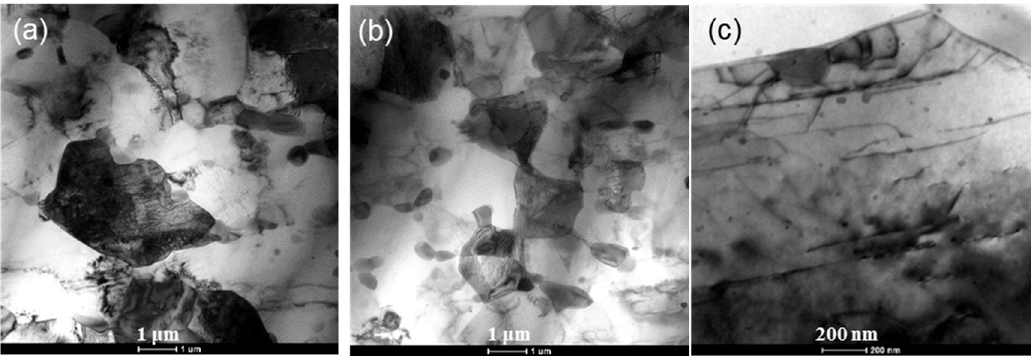
Figure 4. TEM micrographs of H-ECAP AZ91 alloy: ( a , b ) matrix grains surrounded by small-size β -Mg 17 Al 12 precipitates; ( c ) dislocations and nano-sized β‐ Mg 17 Al 12 precipitates inner the matrix grain.